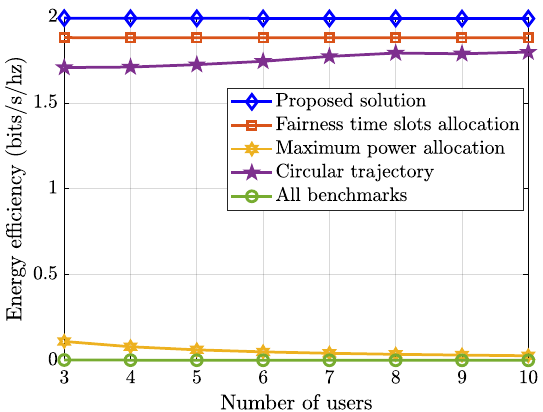
Figure 8. Maximum EE versus number of users comparing the proposed solution to other benchmarks when N = 3 : 10, L =